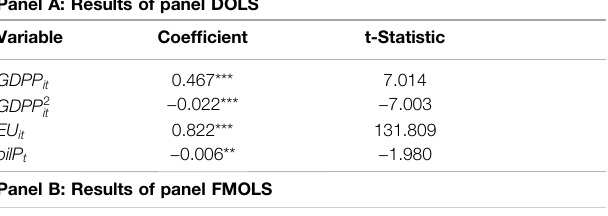
TABLE 5 | Estimation results of Eq. 1 by panel DOLS and panel FMOLS. Panel A: Results of panel DOLS